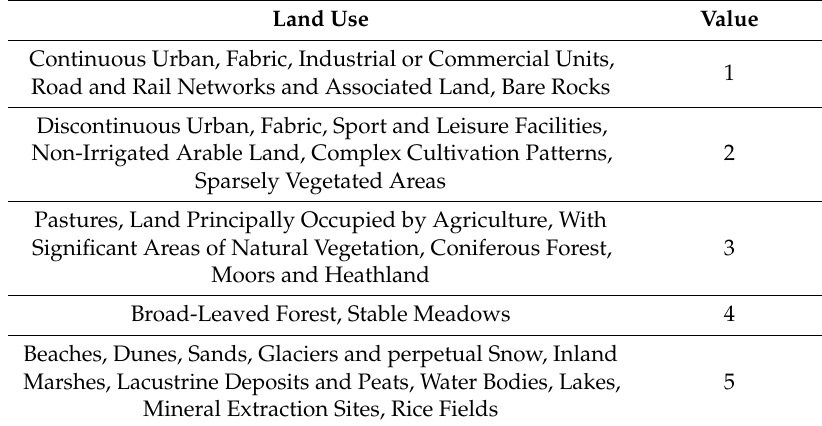
Table 4. Expert classification of Land Use types in Sesia Val Grande UGGp. Land